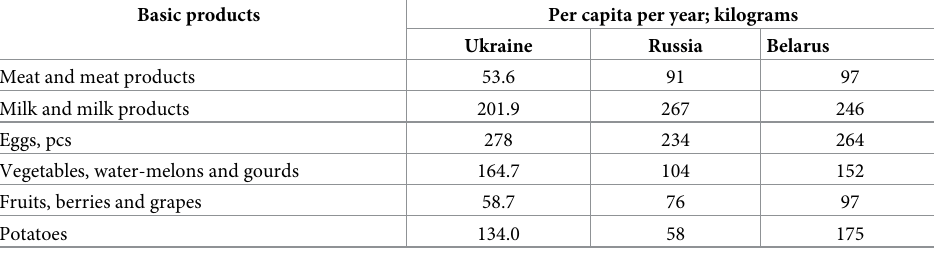
Table 6. Food consumption by the population of Ukraine, Russia and Belarus. Basic